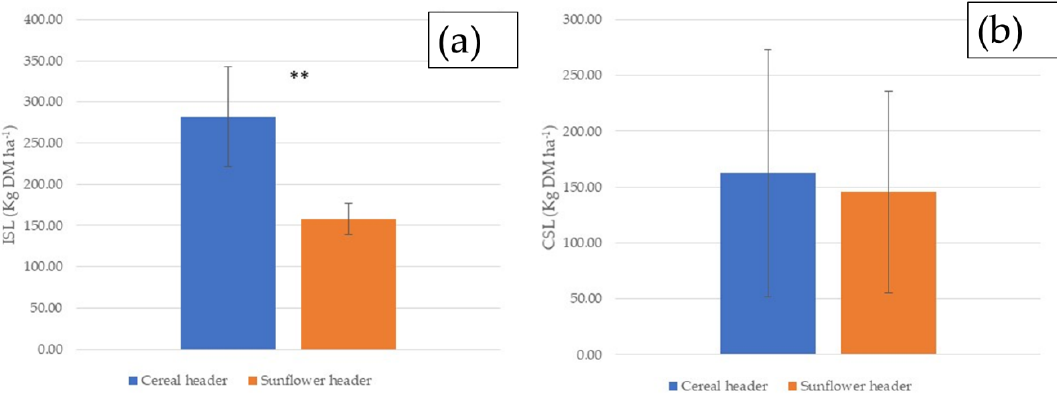
Figure 4. ( a ) Comparison of ISL between the two headers. ( b ) Comparison of CSL between the two headers. “**” indicates statistically significant differences at 0.01% according to t -test.